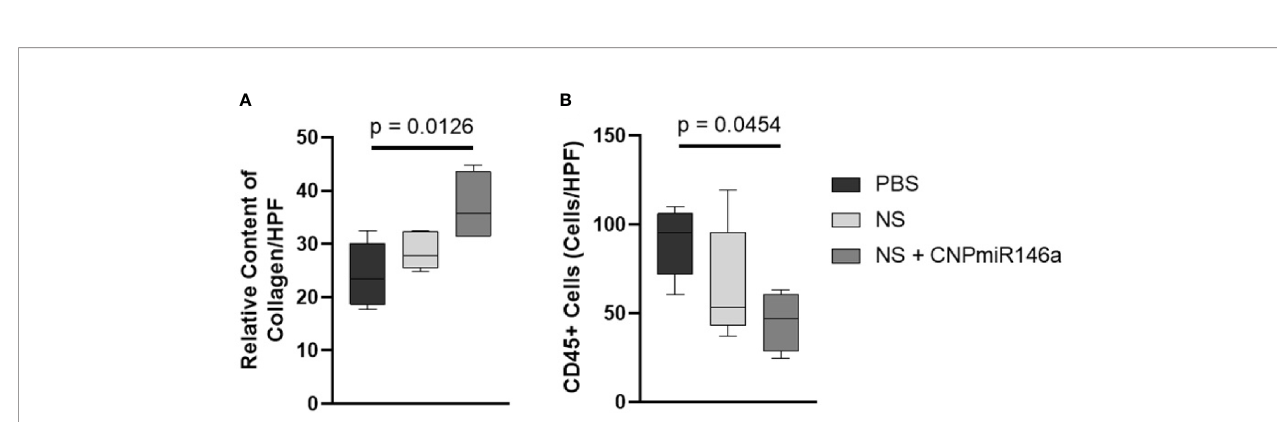
FIGURE 4 | (A) Average collagen level per 400× magni fi cation high-powered fi eld (HPF) was higher in fully healed wounds when wounds were treated with NS + CNP-miR146a. (B) Average CD45+ cell count per 400× magni fi cation HPF was lower in wounds treated with NS + CNP-miR146a 7 days after